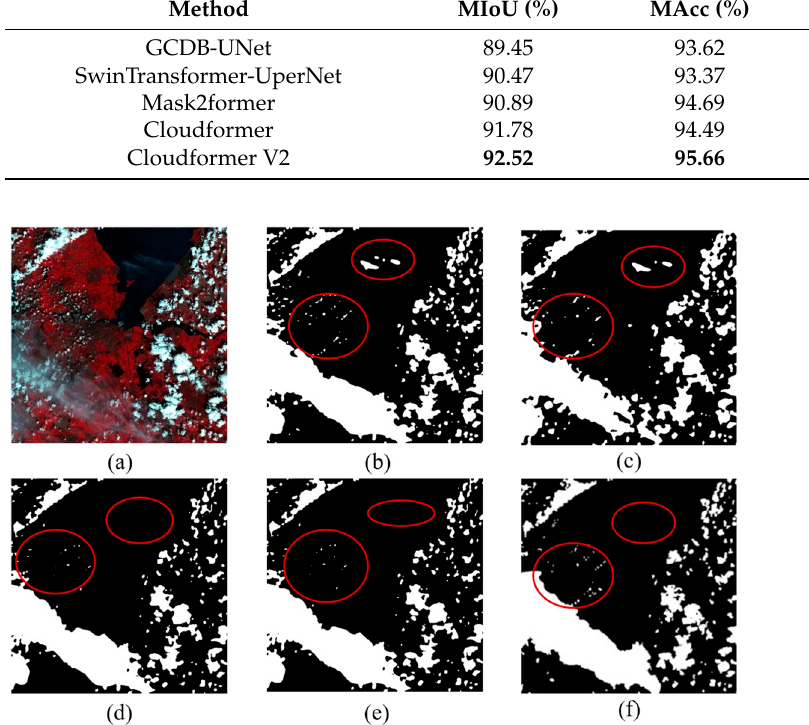
Figure 7. Versus different methods on the GF-1 dataset ( a ) Image. ( b ) Cloudformer V2. ( c ) Cloud- former. ( d ) Mask2former. ( e ) SwinTransformer-UperNet. ( f ) GCDB-UNet.